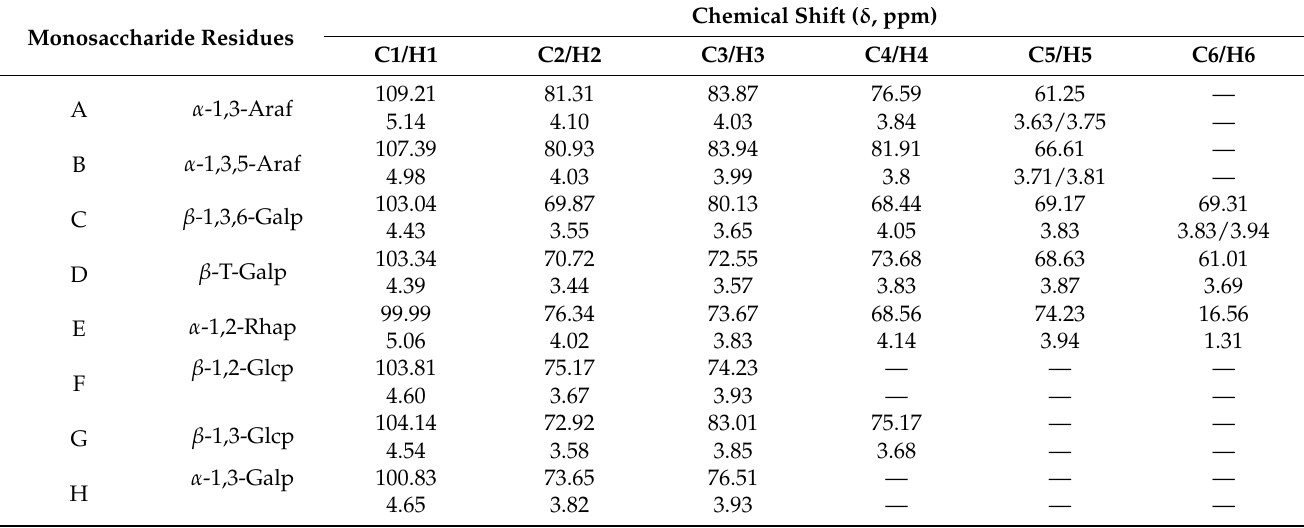
Table 6. The 1 H and 13 C chemical shifts of SSP3